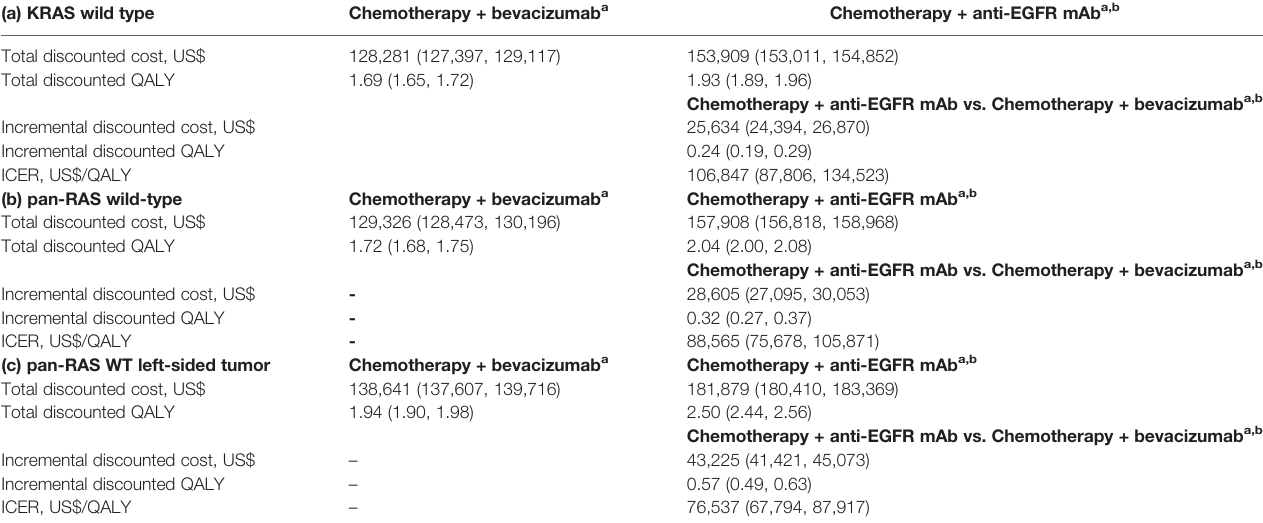
TABLE 2 | Cost-effectiveness comparison of chemotherapy + anti-EGFR mAb vs. chemotherapy + bevacizumab in (a) KRAS wild-type (b) pan-RAS wild-type and (c) pan-RAS wild-type left-sided colonic tumor. (a) KRAS wild